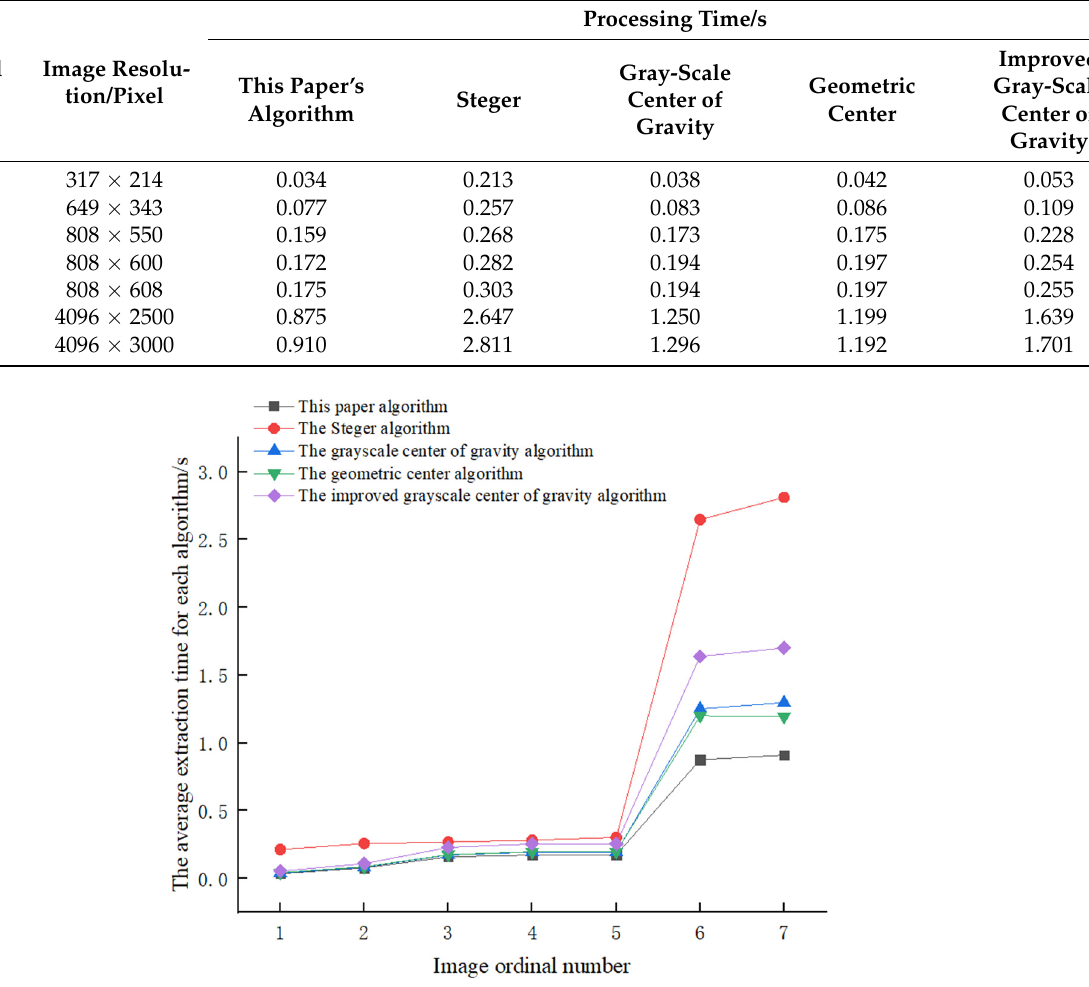
Table 3. The average extraction time for each algorithm.